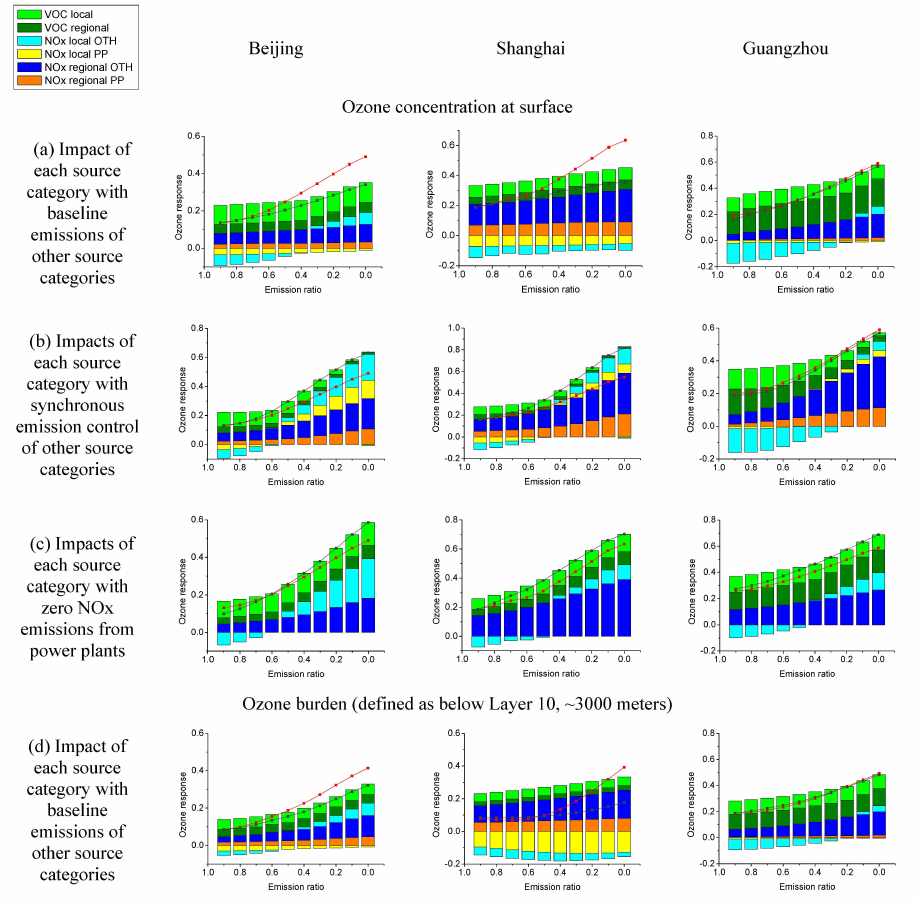
Fig. 11. Ozone response to the stepped control of individual source category in 3 cites. (Ozone response = Change ratio of Ozone/Change ratio of Emission; red solid lines indicate synchronous control of all source categories; colored columns are ozone response to the changes of each emission source category; grey solid lines indicate sum of separate control on each emission source category; all values are averaged of 1-h maxima ozone in high ozone days in July,